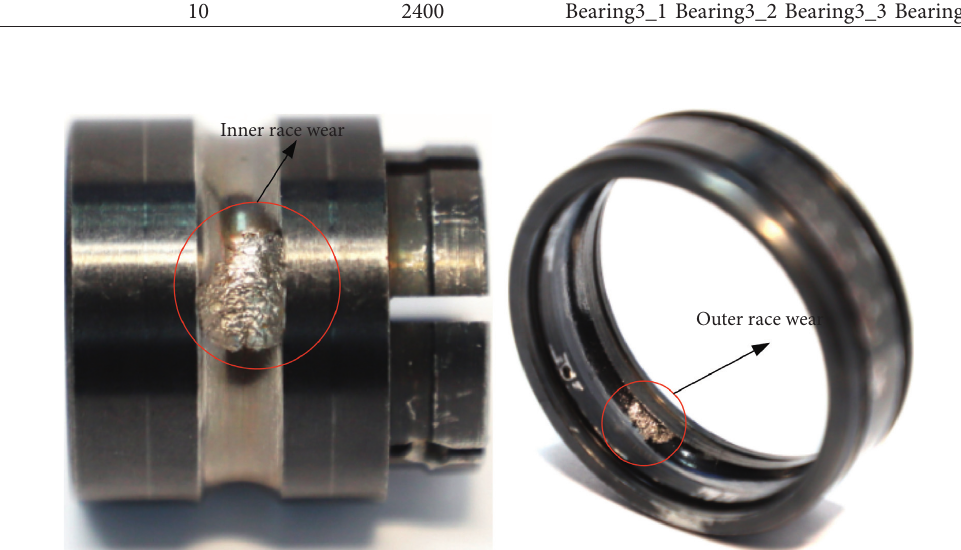
Figure 6: Diagram of faulty bearings.